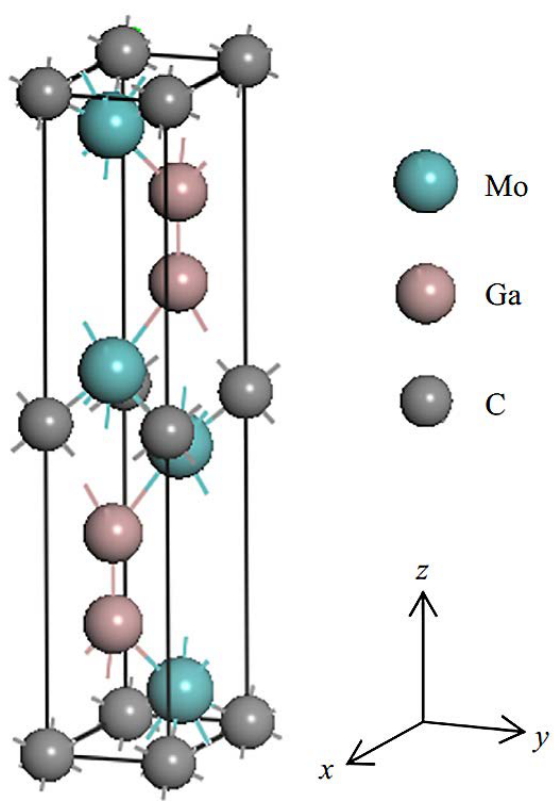
Figure 8. The unit cell of nanolaminated Mo 2 Ga 2 C carbide. Reprinted with permission from [52] 2016 Elsevier.